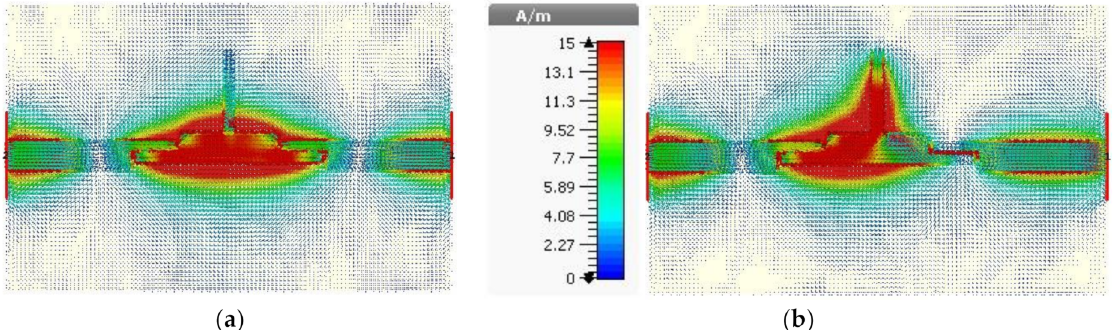
Figure 4. The current distribution of the SL-MMR at L = 8.8 mm and L (cid:48) = 5.5 mm: ( a ) odd mode (f = 3.87 GHz) and ( b ) even mode (f = 4.1